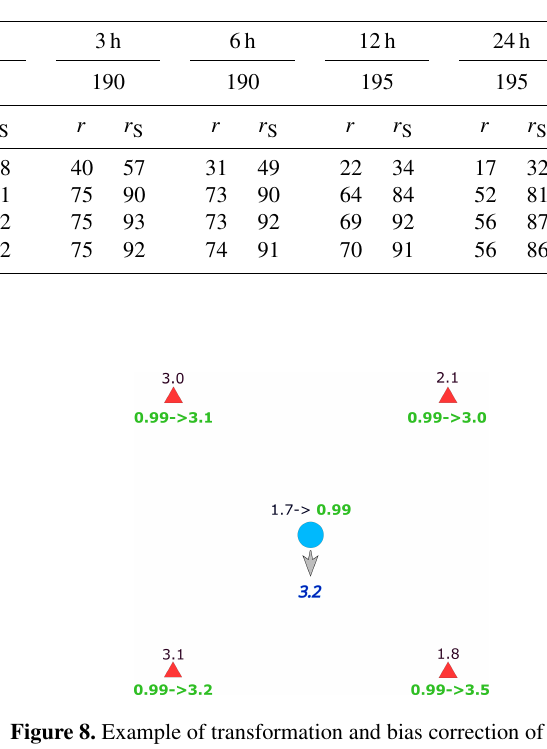
Table 3. Percentage of the stations with improved temporal correlation (compared to interpolation using primary stations only) for the configurations C1–C4.